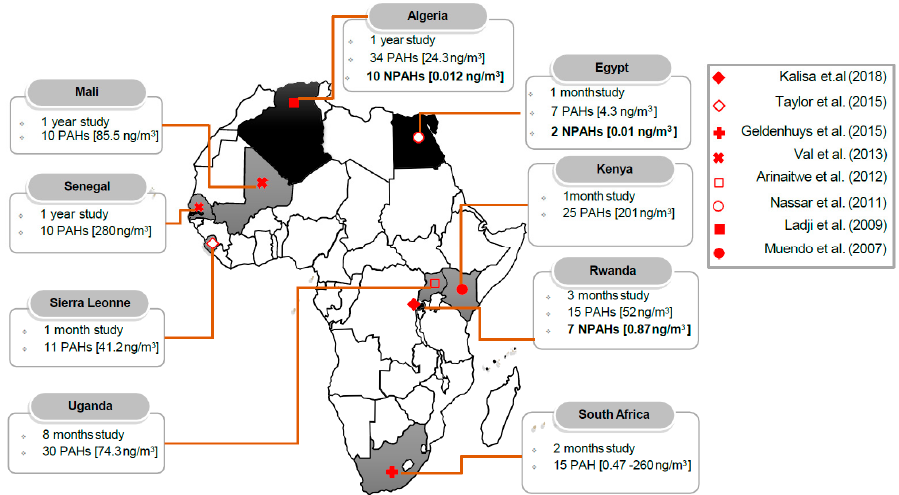
Figure 3. Map of Africa showing countries where studies on polycyclic aromatic hydrocarbons (PAHs) and their nitro-derivatives (NPAHs) in ambient air were conducted. The sampling duration, concentration of PAHs and NPAHs, and number of analyzed PAHs and NPAHs species; shaded black color indicates PAHs and NPAHs studies carried in Algeria [117], Egypt [116], and Rwanda [34] and shaded gray color indicates PAHs studies carried in Kenya [118], Mali [120], Sierra Leonne [121], Senegal [120], South Africa [119], and Uganda